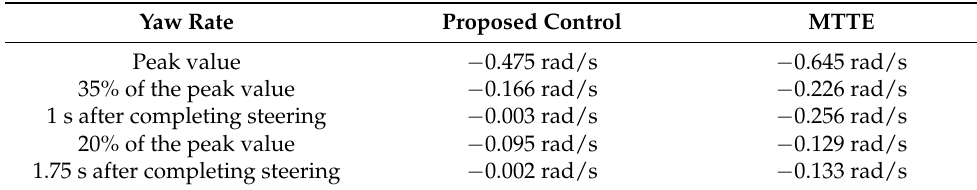
Figure 9. Sine with dwell simulation results on a low-adhesion road: ( a ) yaw rate and steering wheel angle; ( b ) lateral displacement. Table 3. Evaluation of the sine with dwell test.